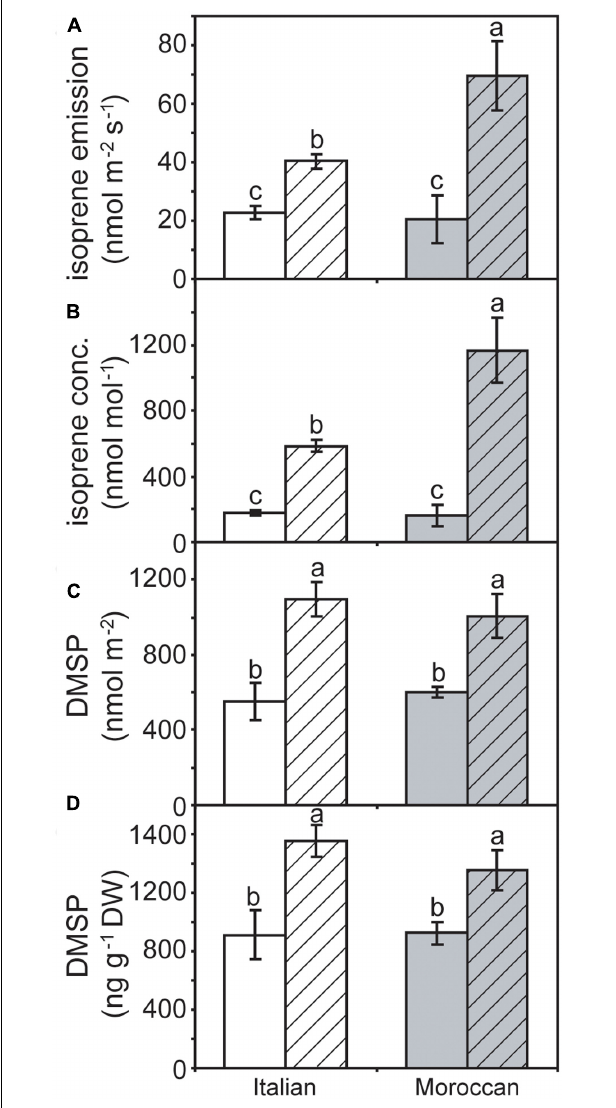
FIGURE 5 | (A) Isoprene emission, (B) the concentration of isoprene within the sub-stomatal air-spaces inside the leaf, (C) dimethylsulphoniopropionate (DMSP) as a function of leaf area, and (D) concentration of DMSP per unit dry mass of leaf matter in Moroccan (gray) and Italian (white) A. donax ecotypes grown in the field under irrigated control (open) and rain-fed drought (hatched) conditions. Error bars indicate one standard error either side of the mean ( n = 6). Letters indicate homogenous groups determined using a one-way ANOVA and LSD post hoc